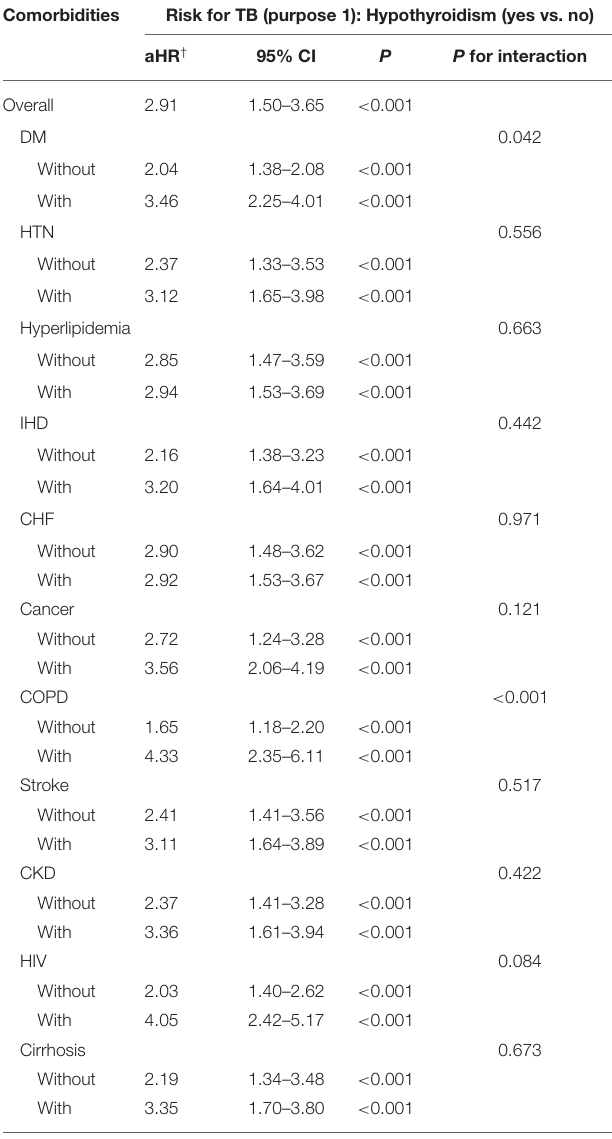
TABLE 3 | Cox proportional hazard regression analysis for the hypothyroidism-linked TB risk with the interaction of comorbidity.